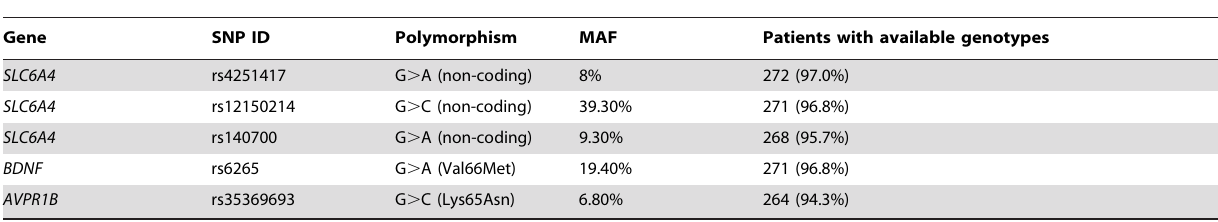
Table 1. Genes and SNPs investigated in this study.